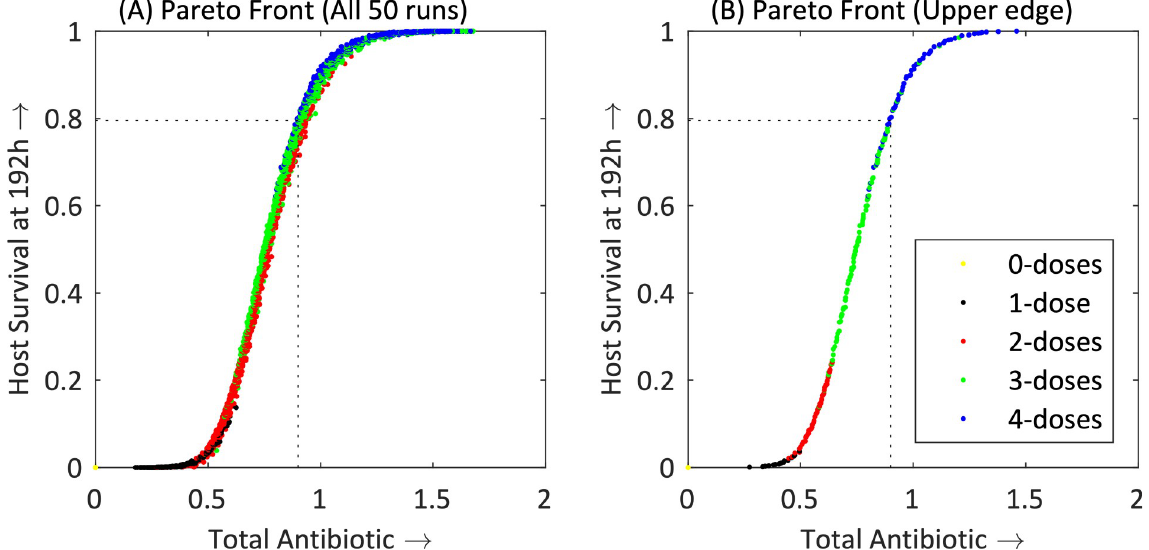
Fig 5. (A) Combined Pareto Fronts for 50 repeat runs; (B) subset of points along the upper edge of combined Pareto Fronts in (A). Both graphs show the trade-off between the total amount of antibiotic used in a treatment regimen and maximum host survival at 192 h. The colours of the points represent the number of (non-zero) antibiotic doses used to achieve that optimal point. Population = 50, generations = 80, model runs = 5000, repetitions =